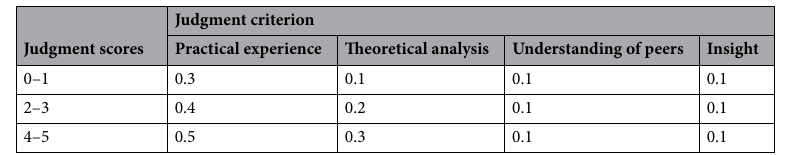
Table 2. Judgement basis and the degree of